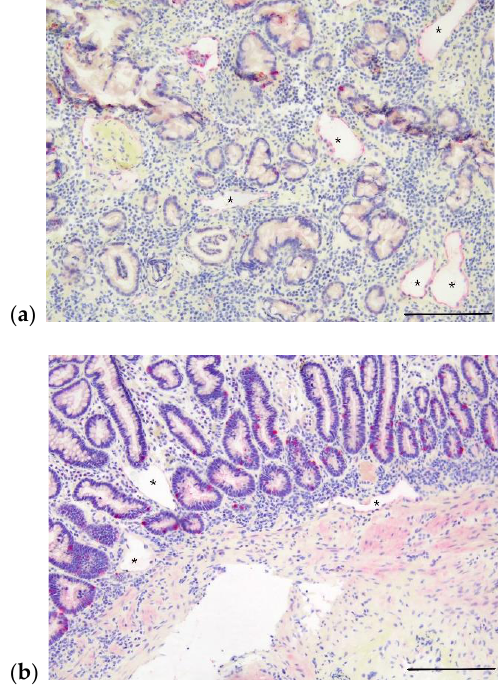
Figure 3. Photomicrographs of apparent lymphangiectasia in deeper layers of small intestine in two dogs with PLE without a diagnosis of lymphangiectasia on routine histologic examination. Intestinal lymphatics indicated by asterisks and immunohistochemically labeled with LYVE-1. ( a ) Apparent mucosal lymphangiectasia in a 9-year-old, male, castrated Australian shepherd dog with PLE; ectatic lacteals denoted by asterisks. Scale bar = 200 µ m. ( b ) Apparent mucosal and submucosal lymphangiectasia in a 6-year-old, male, castrated Bernese mountain dog with PLE; ectatic lacteals denoted by asterisks. Scale bar = 200 µ